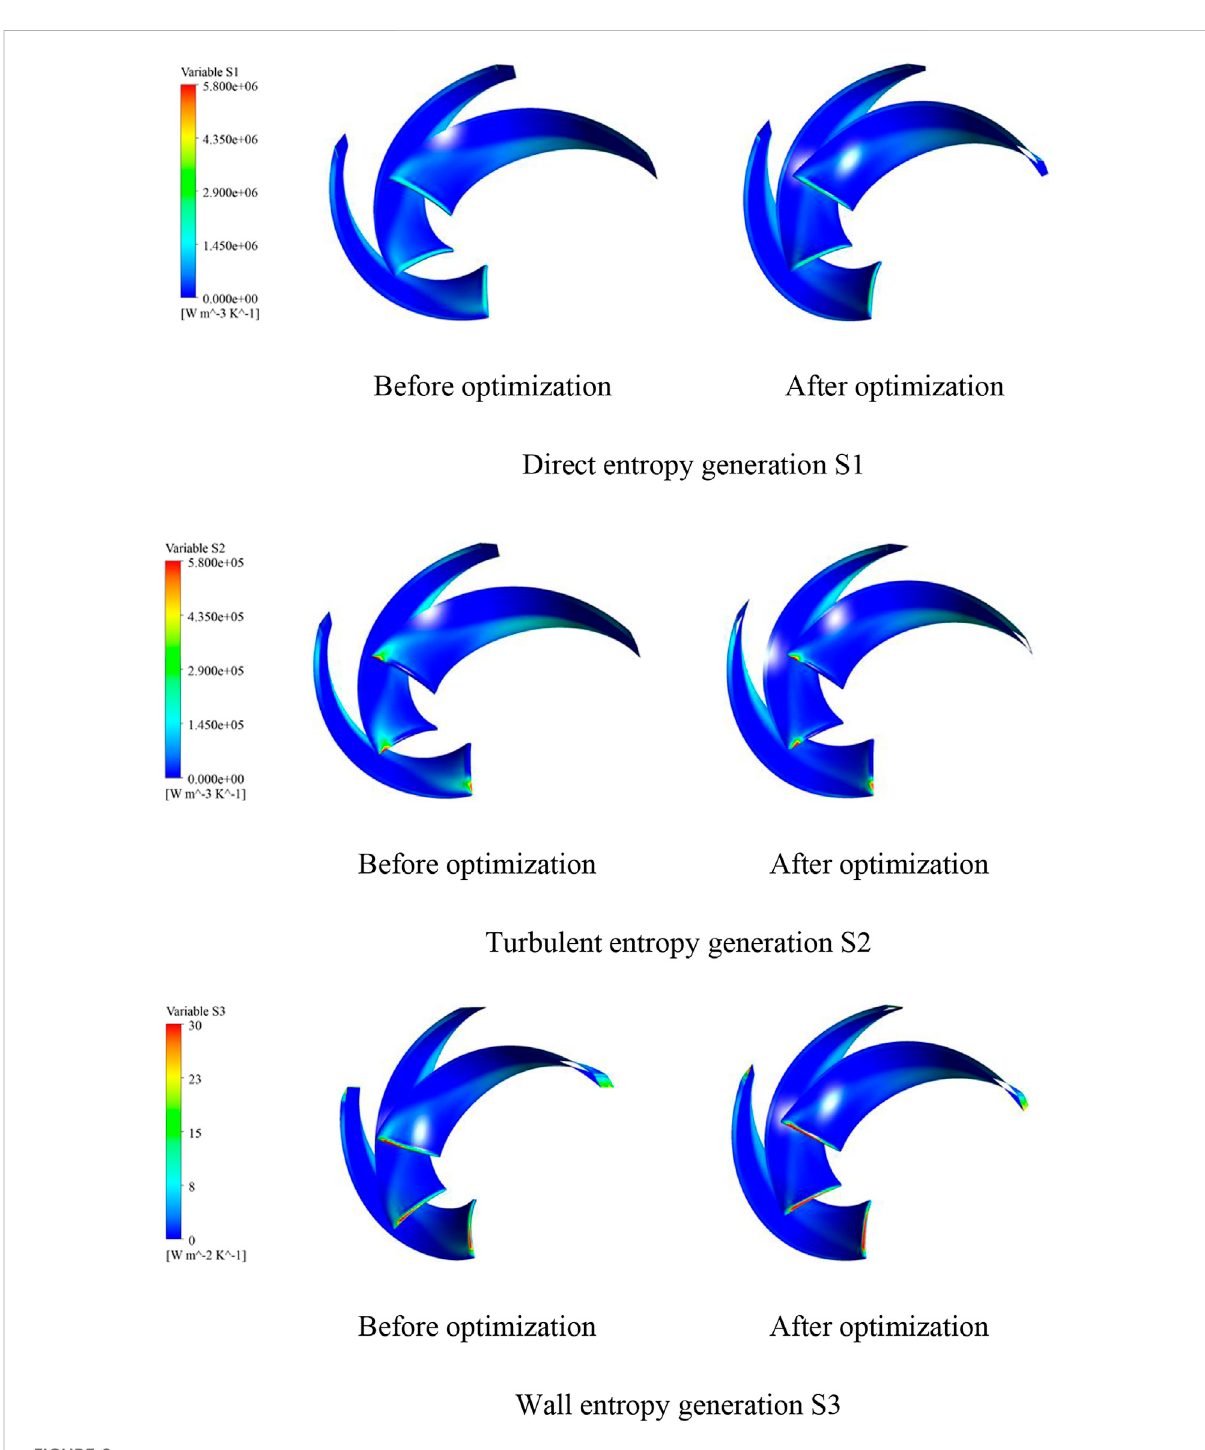
FIGURE 8 Different types of entropy generation cloud